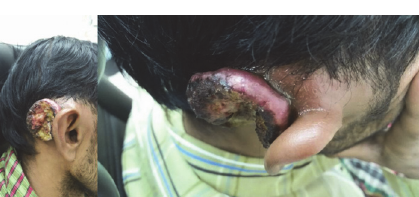
Figure 4: A 4cm by 5 cm right postauricular ulcer with raised edges and a necrotic